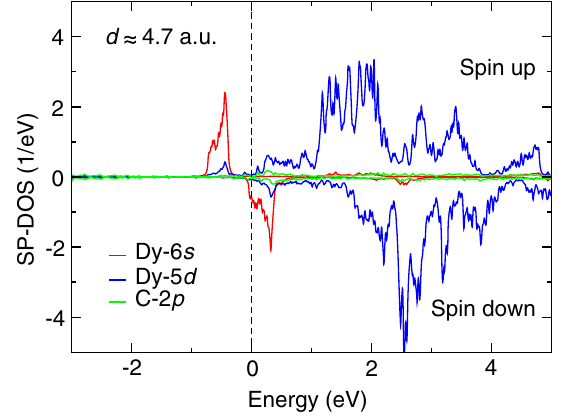
FIG. 5. Spin-polarized DOS around E Dy and 2 p shell of C. The dashed line marks E mRy has been